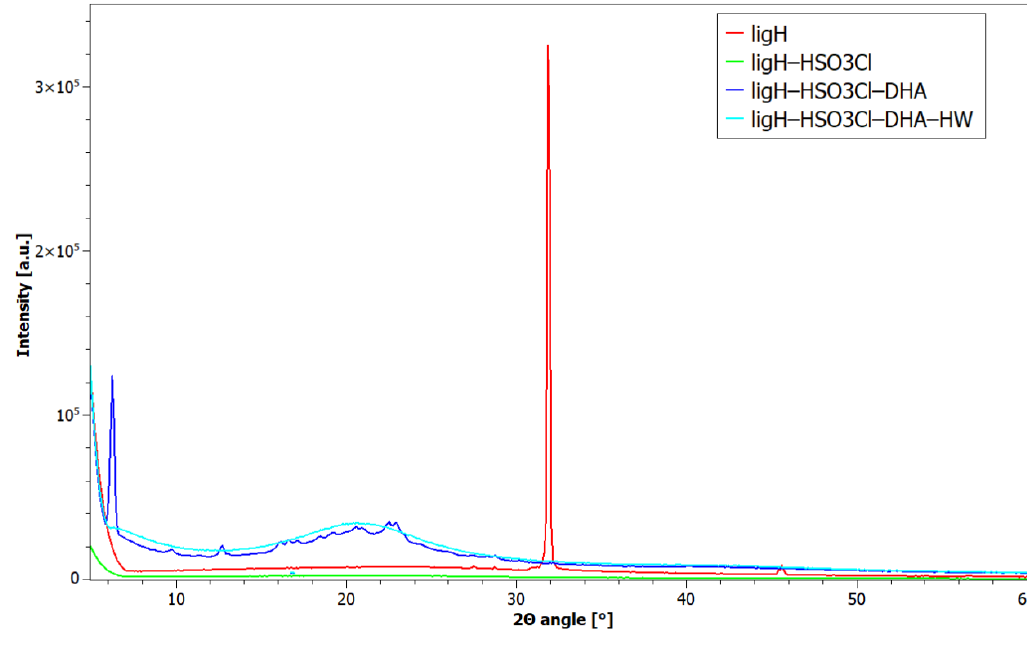
Figure 5. Diffraction patterns of the investigated materials.